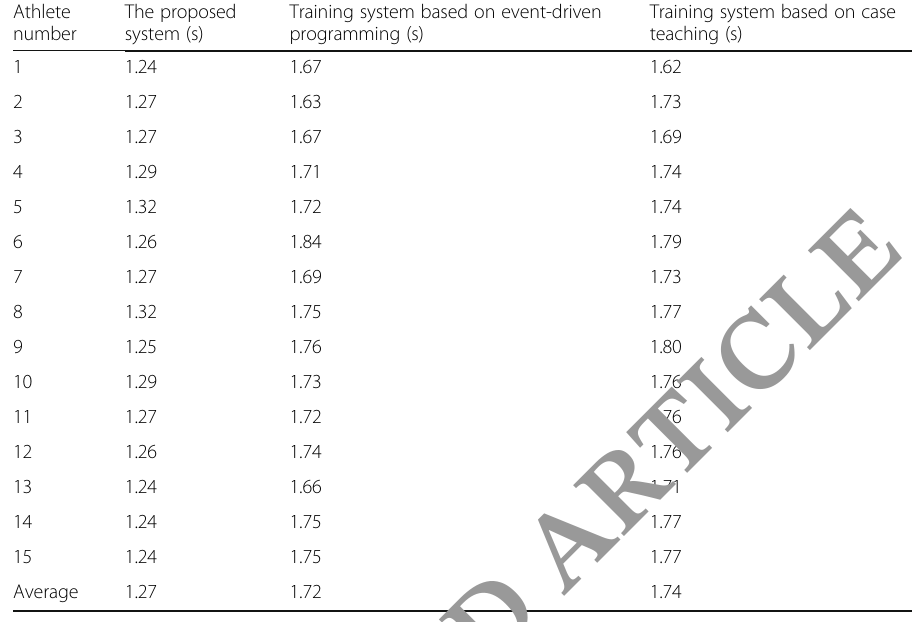
Table 2 Time consuming for movement simulation of different systems (s) Athlete The proposed Training system based on event-driven number system (s) programming (s)